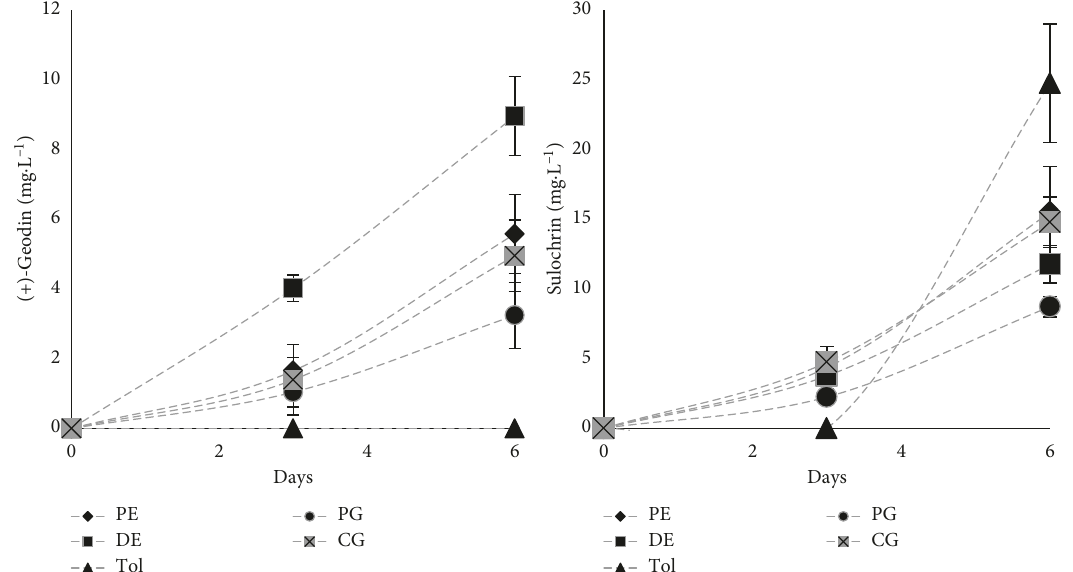
Figure 2: The (+)-geodin and sulochrin production under different substrates. (+)-geodin is the highest under the DE pretreatment, while sulochrin is the highest when Tol is used as pretreatment.